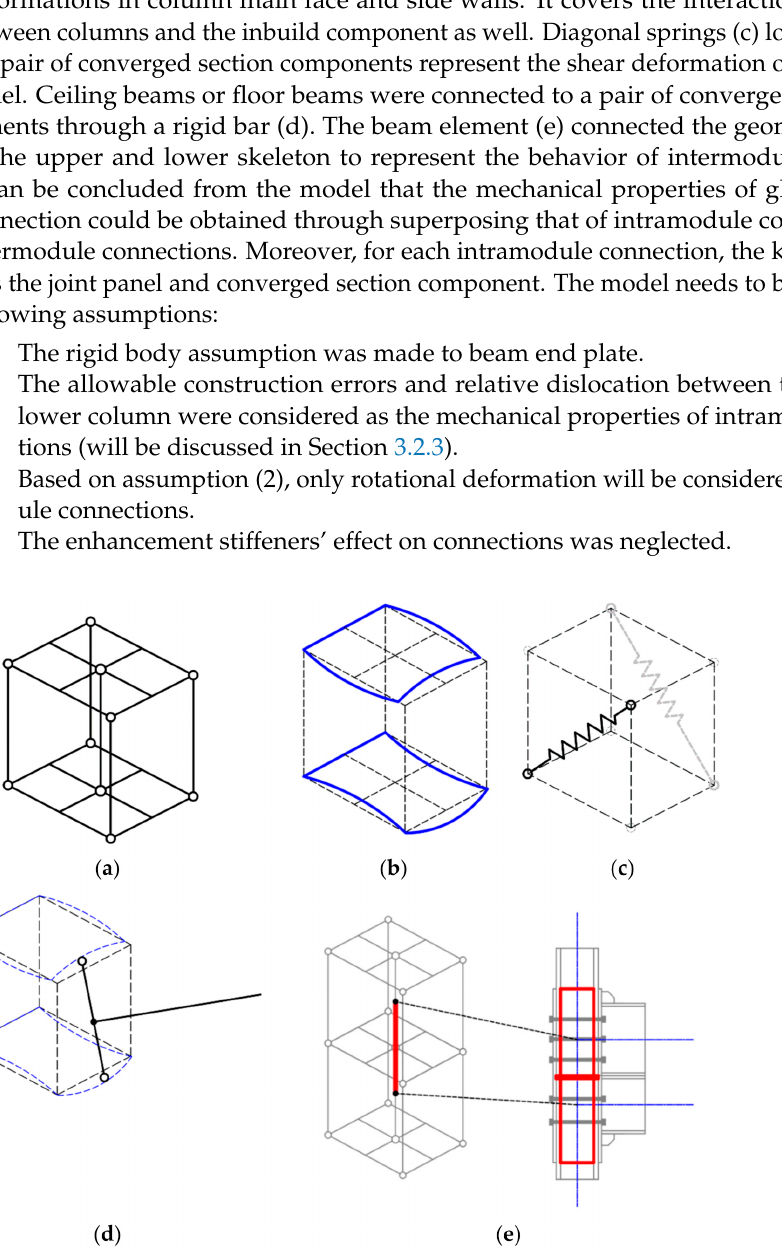
Figure 31. The component deformation mode of novel modular connections: ( a ) The skeleton; ( b ) Converging section component; ( c ) Diagonal springs; ( d ) Beam connection; ( e ) The beam element (intermodule